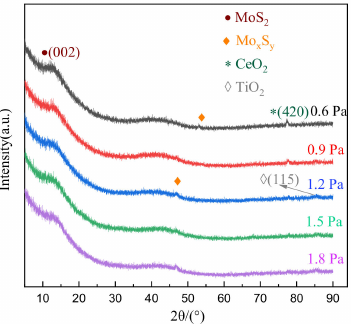
Figure 4. GIXRD curves of the composite coatings deposited at different Ce-Ti deposition